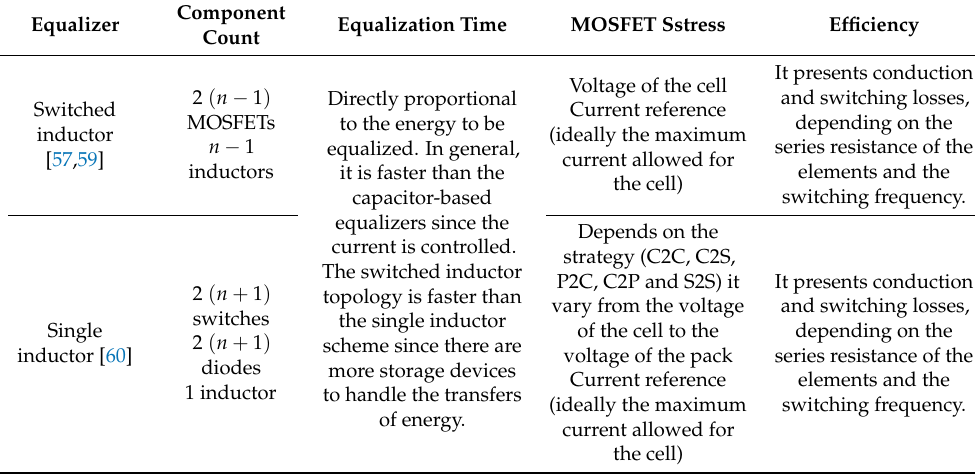
Figure 24. Equalization of a four-cell battery bank using the single inductor scheme. Table 4. Comparative analysis of inductor-based